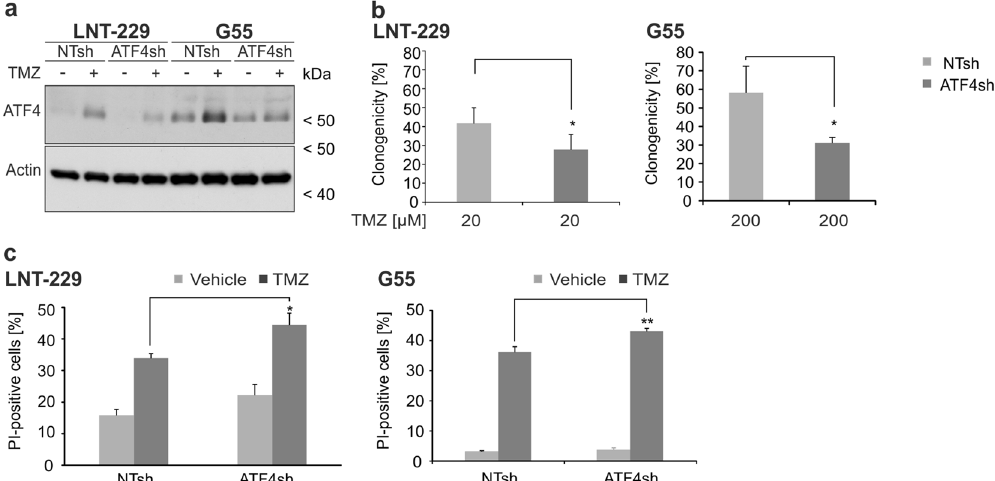
Figure 3. Gene suppression of ATF4 sensitizes human GB cells to temozolomide induced stress. ( a ) LNT-229 and G55 control (NTsh) or ATF4 knockdown (ATF4sh) cells were treated with 400 µM temozolomide (TMZ) in serum-free DMEM for 8 h. Cellular lysates were analyzed by immunoblot with antibodies for ATF4 and actin. ( b ) LNT-229 and G55 NTsh and ATF4sh cells were treated with 20 µM TMZ or 200 µM TMZ respectively for 24 h and were further allowed to grow in DMEM for 5 days. Clonogenicity is shown relative to vehicle (DMSO) (n = 3, mean ± SD, *p < 0.05, Student’s t-test). ( c ) LNT-229 and G55 NTsh and ATF4sh cells were treated with 800 µM TMZ for 72 h in serum-free DMEM. Cell death was analyzed by propidium iodide (PI) staining and quantified by flow cytometry (n = 3, mean ± SD, *p < 0.05, **p < 0.01, Student’s t-test). Data were analyzed with BD FACS Diva software (version